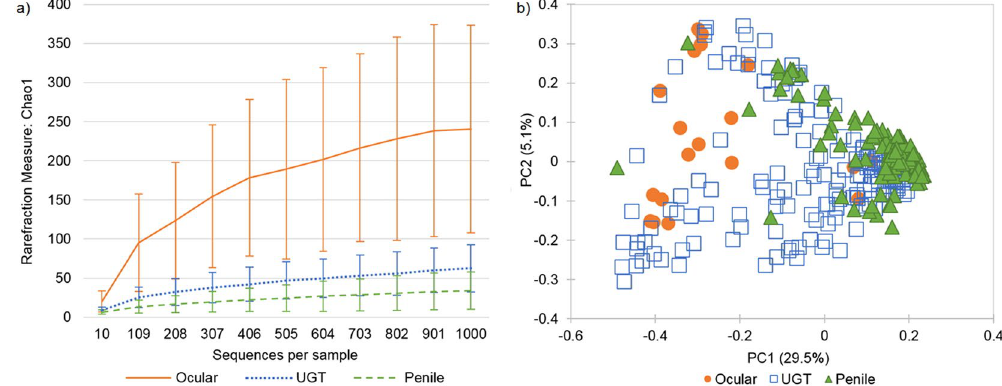
Figure 1. Comparison of ocular, penile and UGT microbiota from free-ranging koalas. ( a ) Phylotype richness inferred using Choa1 metric with error bars showing the standard deviation of each sample type. ( b ) PCoA of weighted UniFrac distances across all samples, as defined by sample